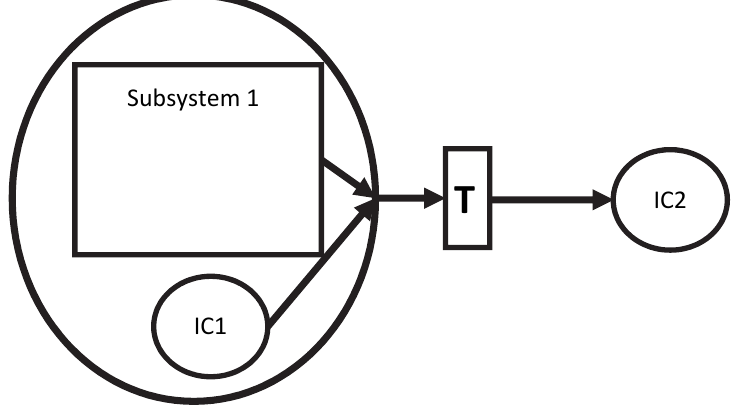
Fig. 1. Layout of an overall system constructed based on the instructions